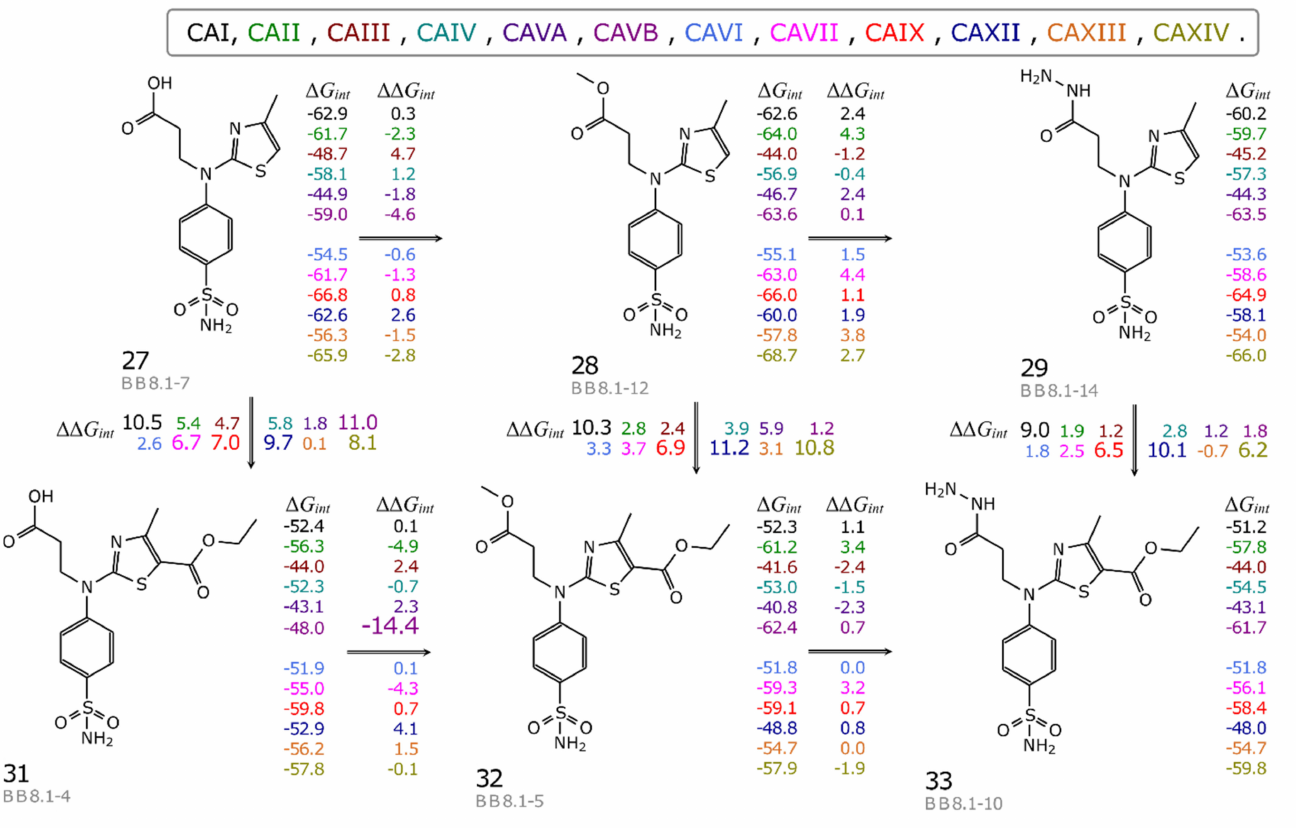
Figure 4. The map of correlation between compound chemical structures and the changes of the standard intrinsic Gibbs energies of binding (kJ/mol). The energies for compound binding to each CA isozyme (colored according to the list above the map) are listed on the right of each compound, while the differences between the values of neighboring compounds are listed above and below the connecting